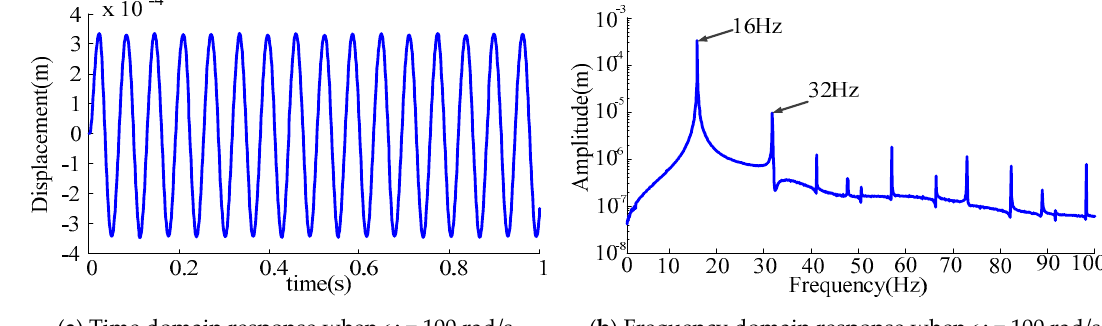
Figure 3. Response of rotor-bearing system under low speed condition.